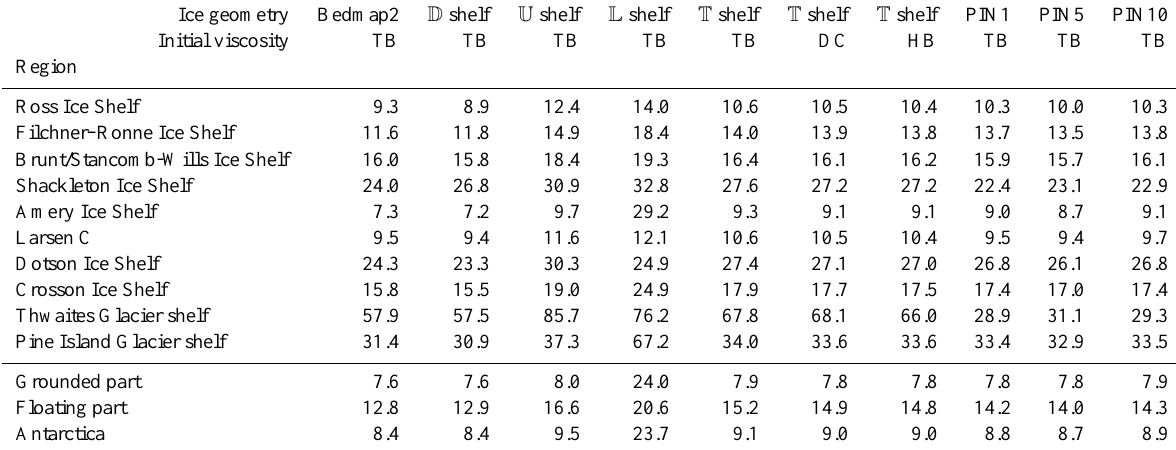
Table 1. RMS deviation between simulated and observed velocity components for different regions. For the inversion, different option to ensure flotation on the ice shelves are assessed. As a reference, the input geometry is kept while assuming a constant ice density (Bedmap2). A second option is to locally adjust the density field on the ice shelves according to flotation ( D ). Otherwise, an a priori adjustment of the geometry is necessary, keeping either the upper surface ( U ), the lower surface ( L ) or the thickness of the ice shelves ( T ) from Bedmap2. For initialising the viscosity parameter on the shelves, three options are assessed based on inferred ice temperatures (TB), a local hydrostatic balance (HB) or a compromise of both used to identify damaged ice (DC). Complementary information on pinning points (Sect. 2.4.3) is accounted for in the inversion dependent on their distance from the Bedmap2 grounding line. Data are included if the distance is larger than either 1, 5 or 10km, referred to as setup PIN1, PIN5 and PIN10 respectively.